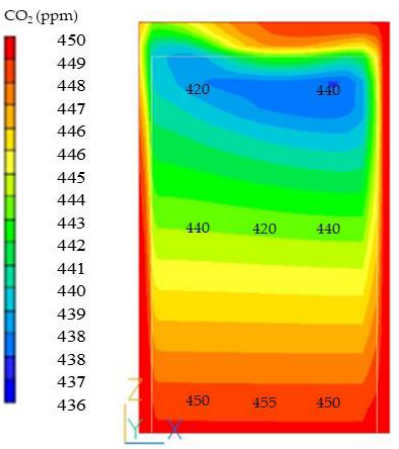
Figure 8. The CO 2 distribution inside the chamber: The values are the measured data of the CO 2 concentration.